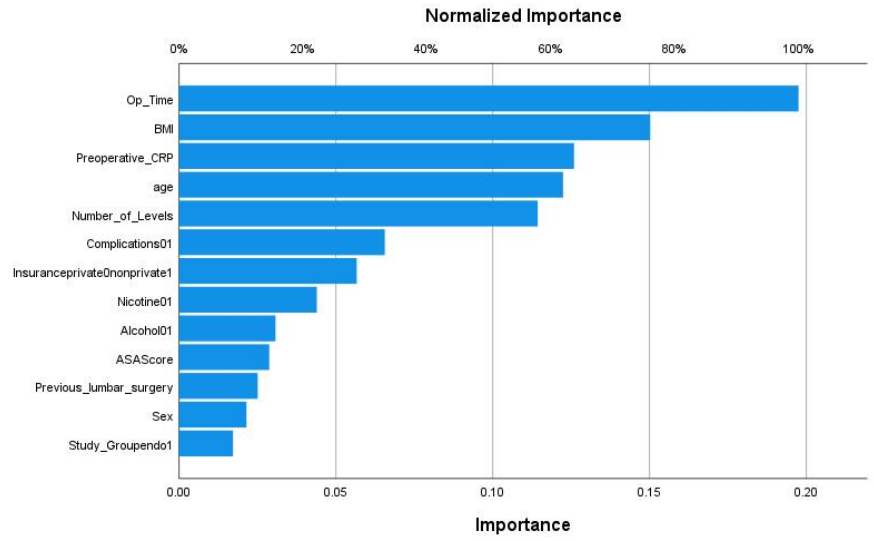
Figure 4. Feature importance analysis for predicting the hospital length of stay classes in the multi- layer perceptron model.